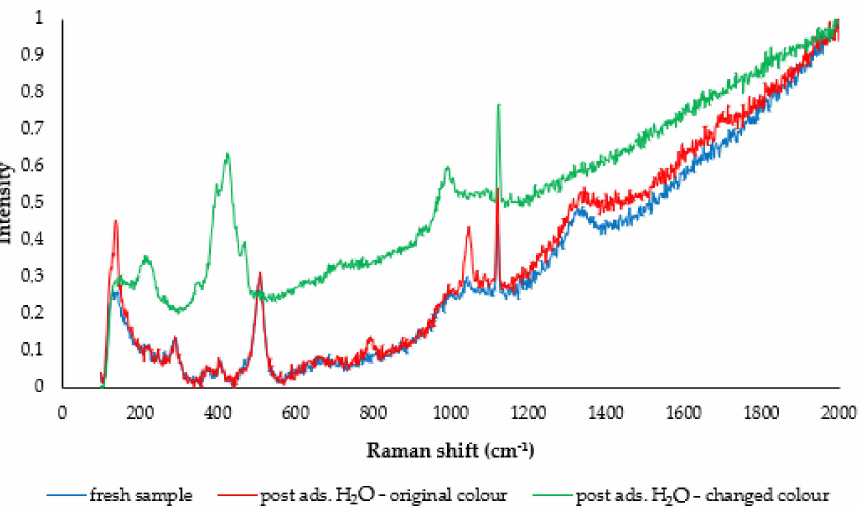
Figure 8. Raman spectra of fresh sample, compared with post wet adsorption 13X zeolites sample with the original and changed